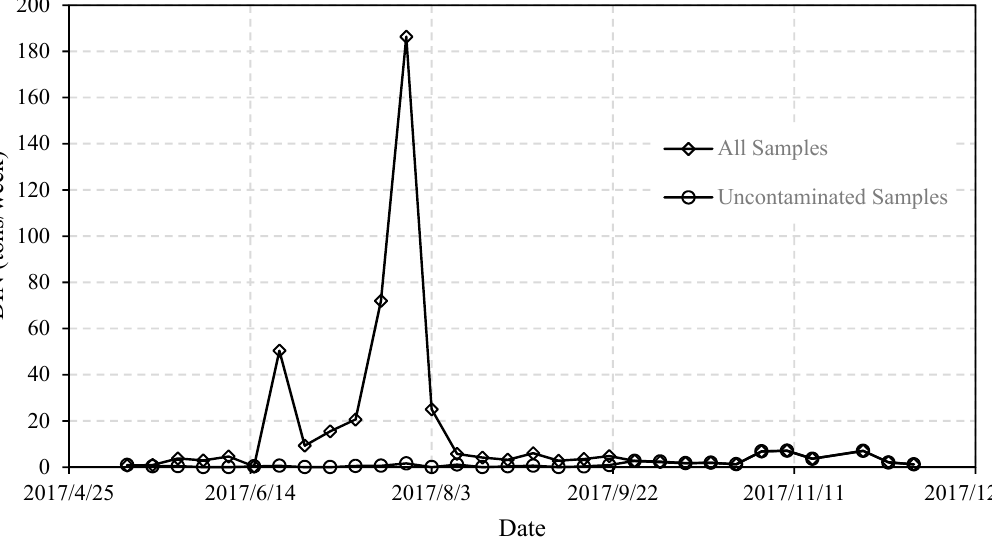
Figure 6. Utah Lake TP seasonal loading weekly estimates, both high (all samples) and low (uncontaminated samples) estimates.